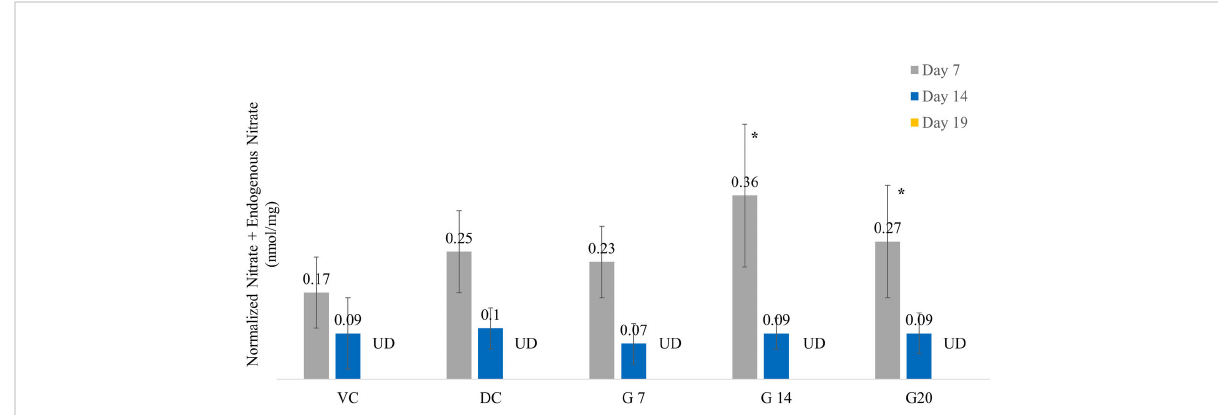
FIGURE 3 Nitric oxide levels across different treatment groups on days 7, 14, and 19. Asterisk indicates p < 0.05 compared with the vehicle control